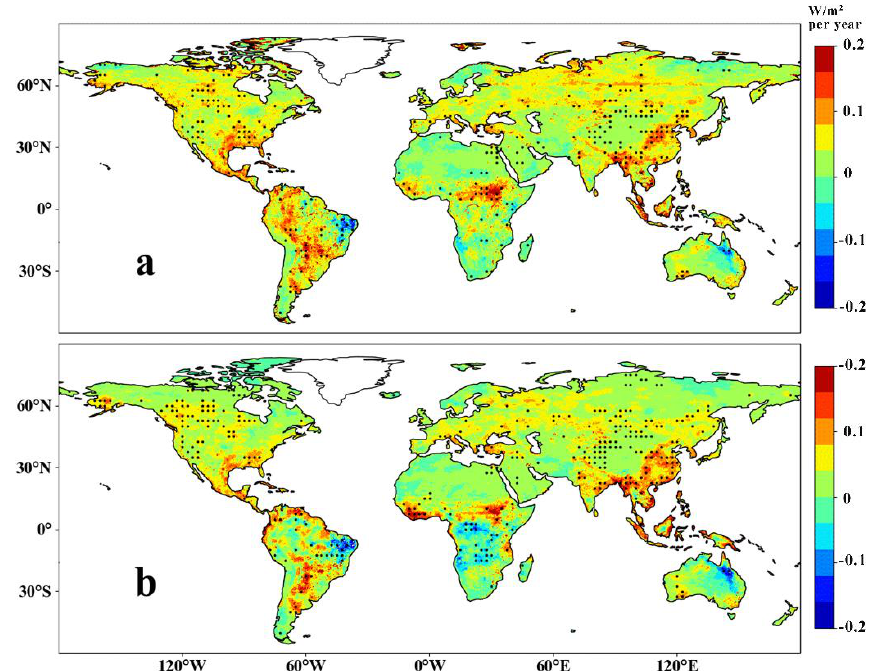
Figure 8. Trends of annual LE (W / m 2 ) of GLASS-based LE ( a ) and MERRA-2-based LE ( b ) during the period of 2007–2017. The black points refer to pixels with 95% confidence.